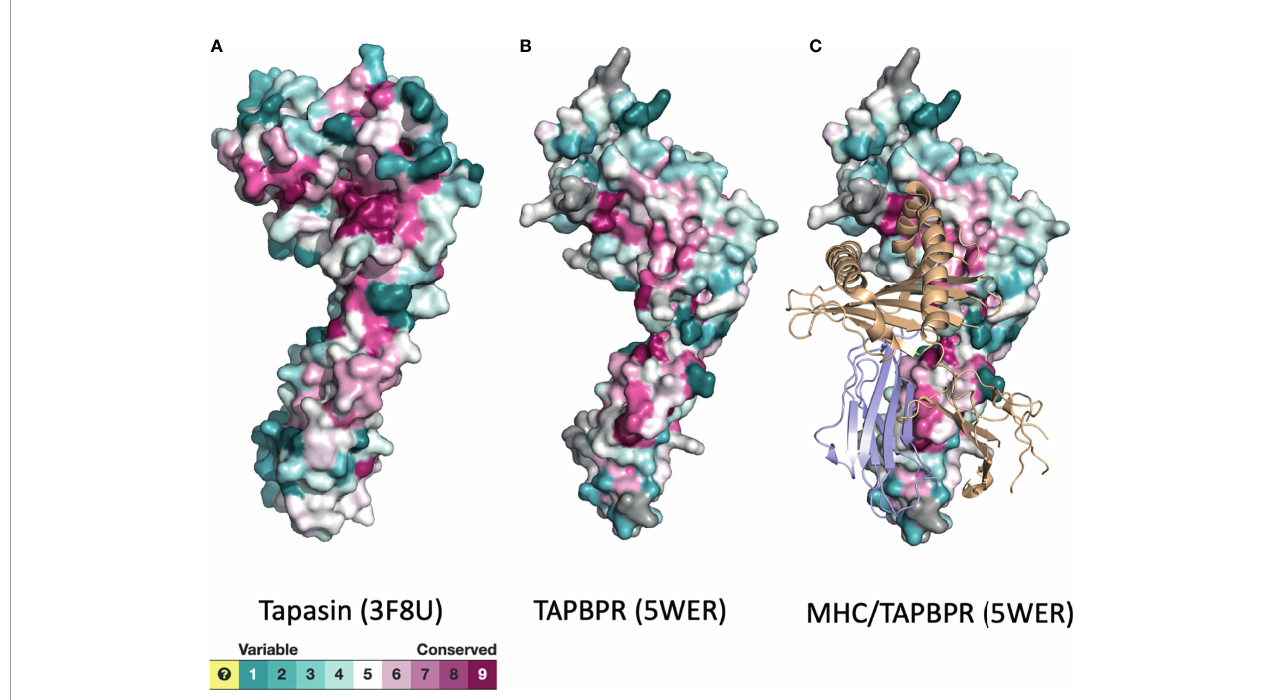
FIGURE 4 | Surface representations of tapasin (A) , TAPBPR (B) , and MHC/TAPBPR complex (C) reveal regions of conservation and variability. PDB models of tapasin (3F8U) and TAPBPR (5WER) were submitted to the Consurf server (45, 46) to assess the evolutionary conservation of the amino acids of the indicated molecules. Color scheme for the degree of variability is